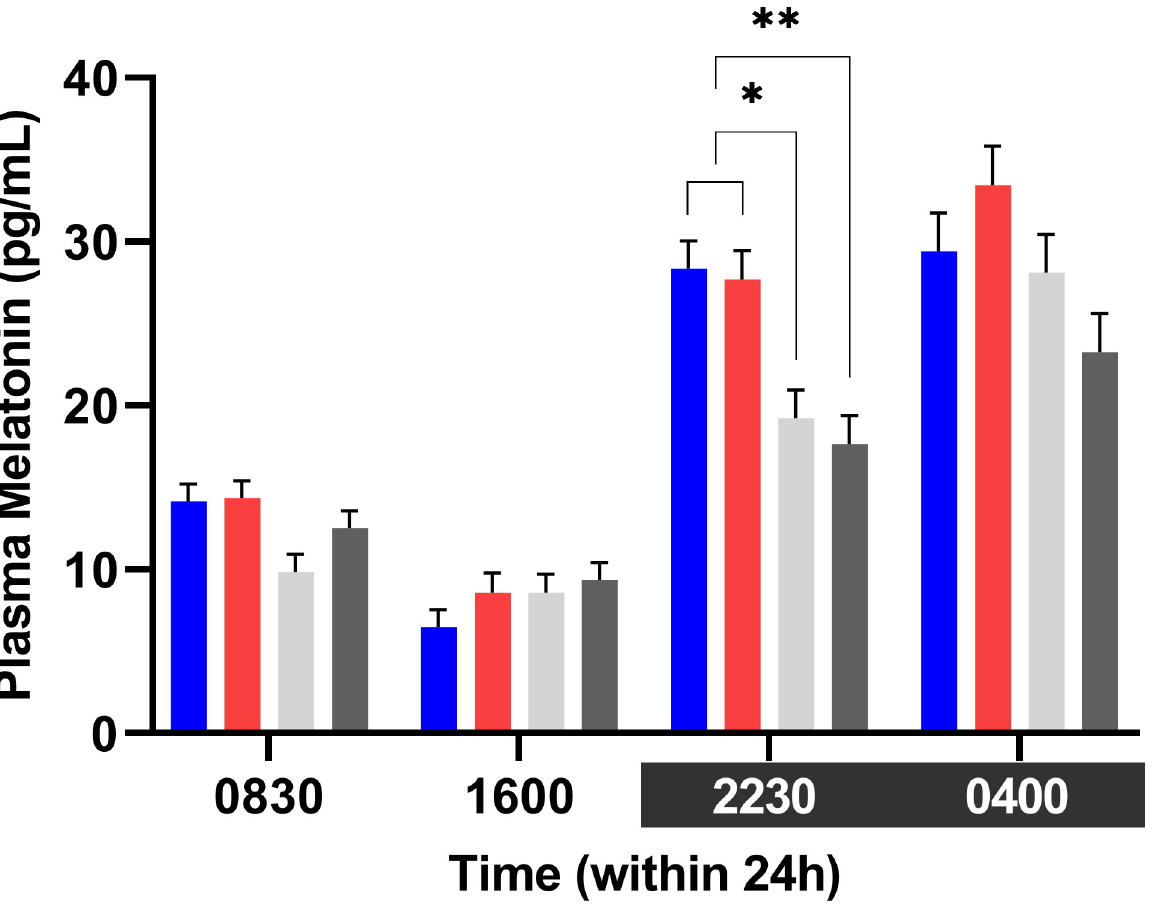
Fig 8. Treatment least squares mean (LSM) of plasma melatonin within 24 hours. Cows exposed to the Blue and Red light treatments had higher plasma melatonin than cows exposed to White light ( � p < 0.1) and White-blue light ( �� p < 0.05). The diurnal rhythm in melatonin concentrations observed here, with the highest concen- trations during the dark period, confirms previous findings in dairy cows [38–40] and younger cattle [22, 41–45]. The melatonin concentration increased rapidly on switching to a low light intensity, which is consistent with previous results [22, 42]. The peak melatonin level was found in the second set of samples after onset of darkness (after 7 hours in the dark), confirm- ing results in several other studies [41, 43, 45, 46]. Interestingly, the Red and Blue light treat- ments caused a more rapid increase in melatonin after the onset of darkness than the White and White-Blue light treatments, contradicting our hypothesis (iii). This could be a period- treatment confounding effect, or cessation of the intense red and blue lights may have elicited more rapid secretion of melatonin. The White-Blue treatment (White light for 10 h, Blue 9 9 light for 6 h) did not cause such a rapid increase in melatonin at night as seen with the Blue treatment (Blue light for 16 h). Thus, the shorter exposure to blue light before the dim night 9 light in the White-Blue treatment may not have been sufficient for a rapid response in melato- nin secretion. The highest melatonin levels were obtained after the long-wavelength Red day- light treatment, although the levels were not significantly different from those in the Blue and White treatments. Elsabagh et al . [22] found that two hours of dim yellow LED light increased melatonin concentration faster than two hours of dim short-wave blue LED light treatment,